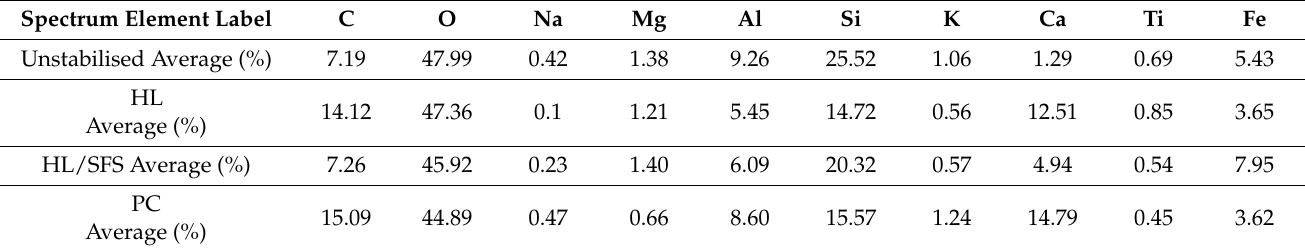
Table 3. EDS spectrum results presented as an average percentage.